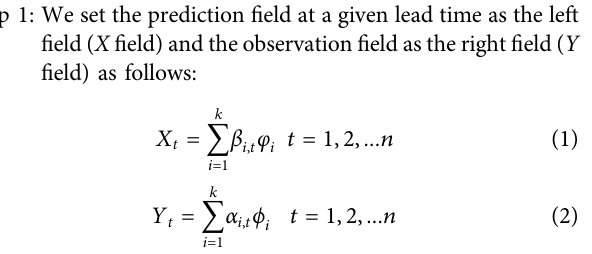
Step 1: We set the prediction fi eld at a given lead time as the left fi eld ( X fi eld) and the observation fi eld as the right fi eld ( Y fi